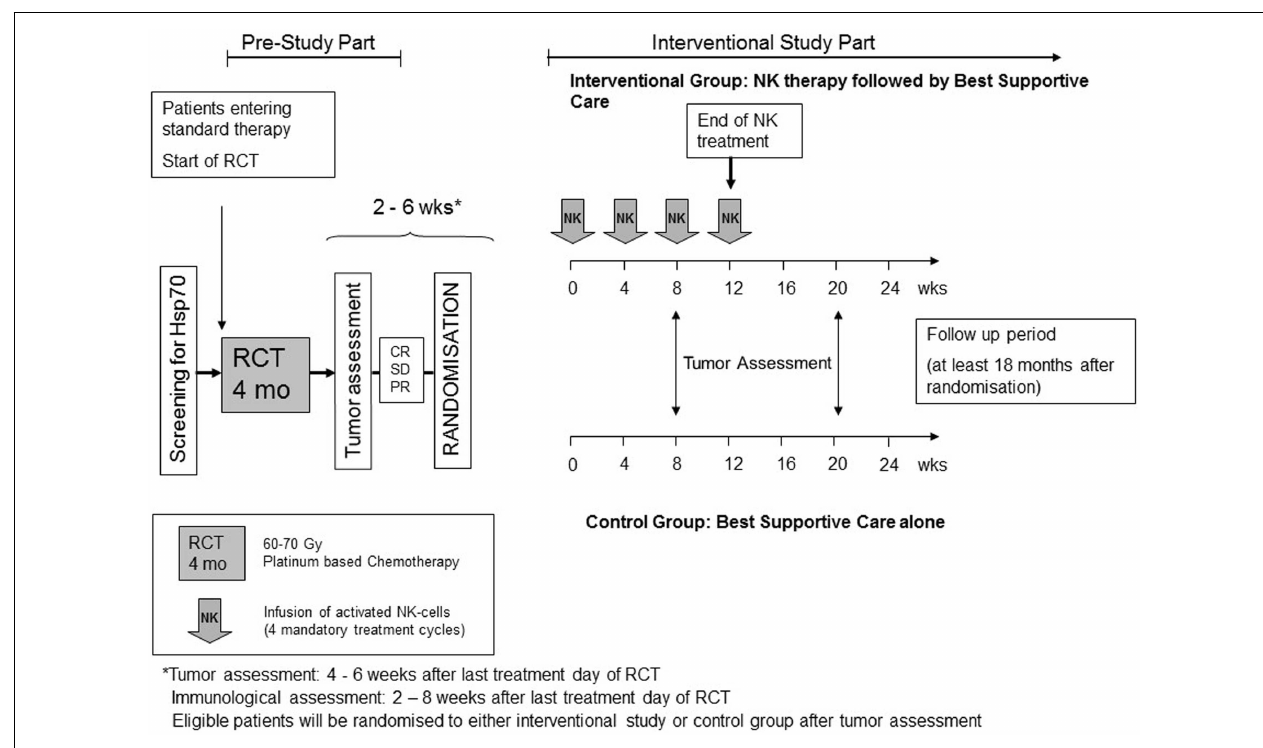
randomized into the trial.The interventional group receives four cycles of ex vivo TKD/IL-2 activated NK cells on a monthly basis; the control group gets best supportive care.Tumors will be assessed in the first year every 2–3months by CT in both